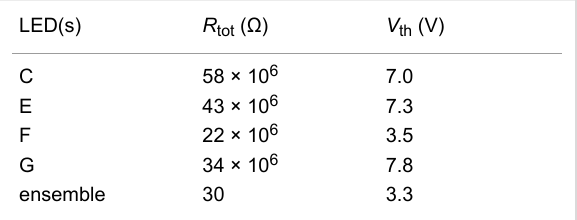
Table 1: Series resistance R tot and threshold voltage V th values of the single NWs C, E, and G, as well as of the bundle of NWs F and the NW